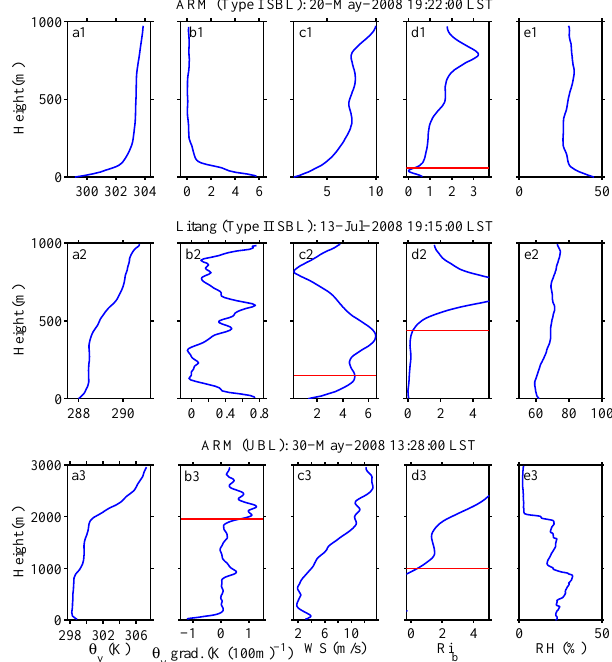
Figure 3. Examples of vertical profiles in type I SBLs (upper panels), type II SBLs (middle panels), and UBLs (lower panels): (a) potential temperature (K), (b) potential temperature gradient (K100m − 1 ), (c) horizontal wind speed (ms − 1 ), (d) bulk Richard- son number Ri b , and (e) relative humidity (%). The red solid lines on (b3) , (c2) , and (d1–d3) denote the PBLH determined by the modified parcel, LLJ, and bulk Richardson number methods, re-